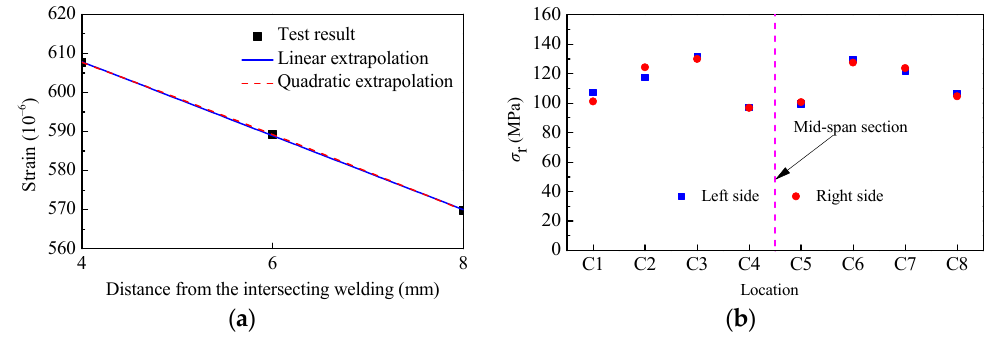
Figure 6. Analysis on hot spot stress: ( a ) extrapolation methods; and ( b ) distribution rule.